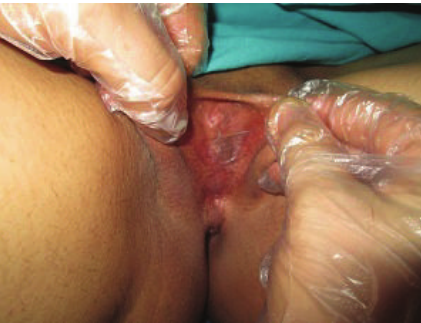
Figure 3: Postoperative 15th day view on